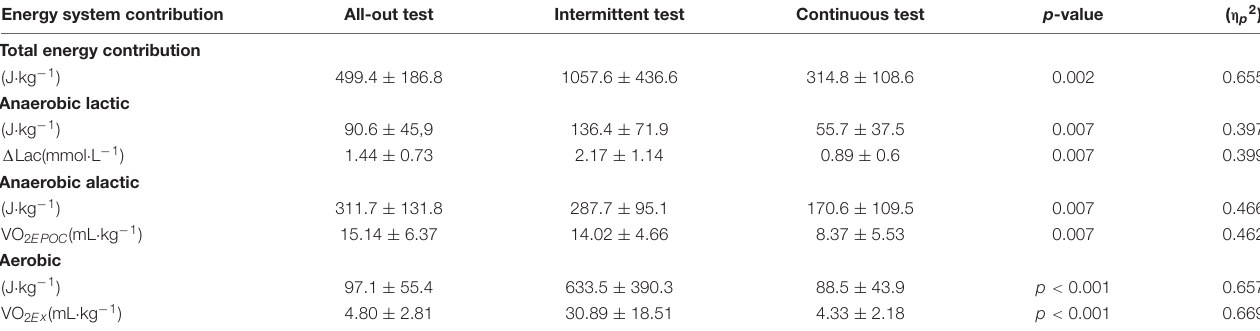
TABLE 3 | Total energy contribution and energy system contribution in particular tests (mean ± SD for all climbers).